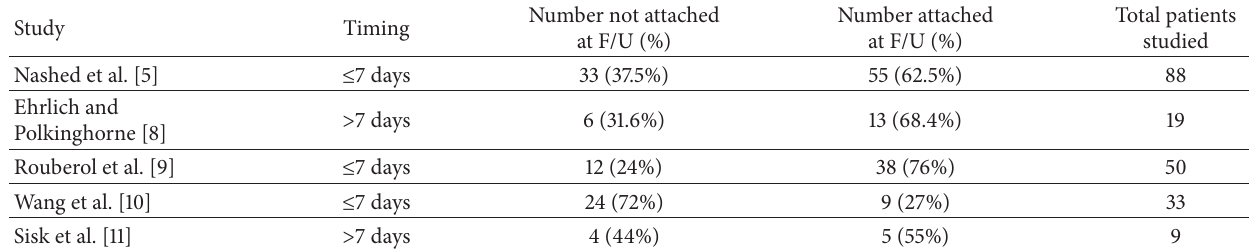
Table 2: Time to intervention versus percent attached at